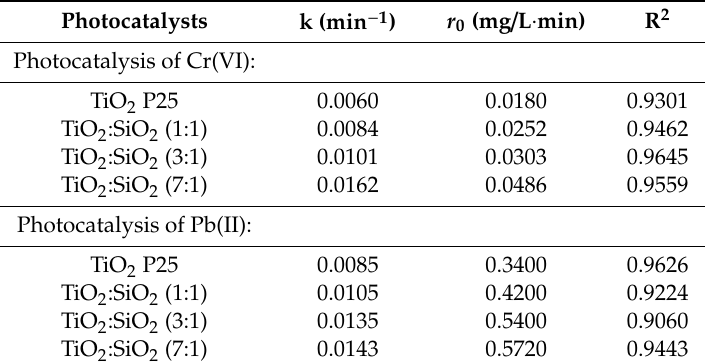
Table 5. The kinetic study of